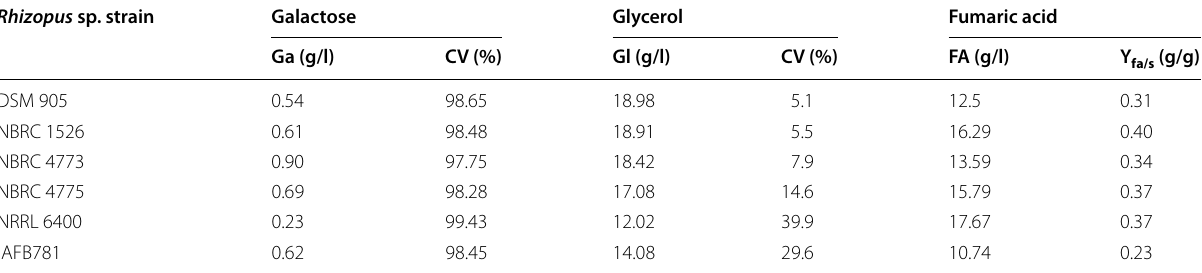
FA (g/l), fumaric acid concentration in medium after culture; Ga (g/l), galactose concentration in medium after culture; Gl (g/l), glycerol concentration in medium after culture; CV (%), consume value; Y fa/s (g/g), g of fumaric acid produced per g of carbon source consumed Table 7 Fumaric acid production from glycerol to mannose by various strains of Rhizopus sp. after 168 h of growth (35 °C, 200 rpm) Rhizopus sp.